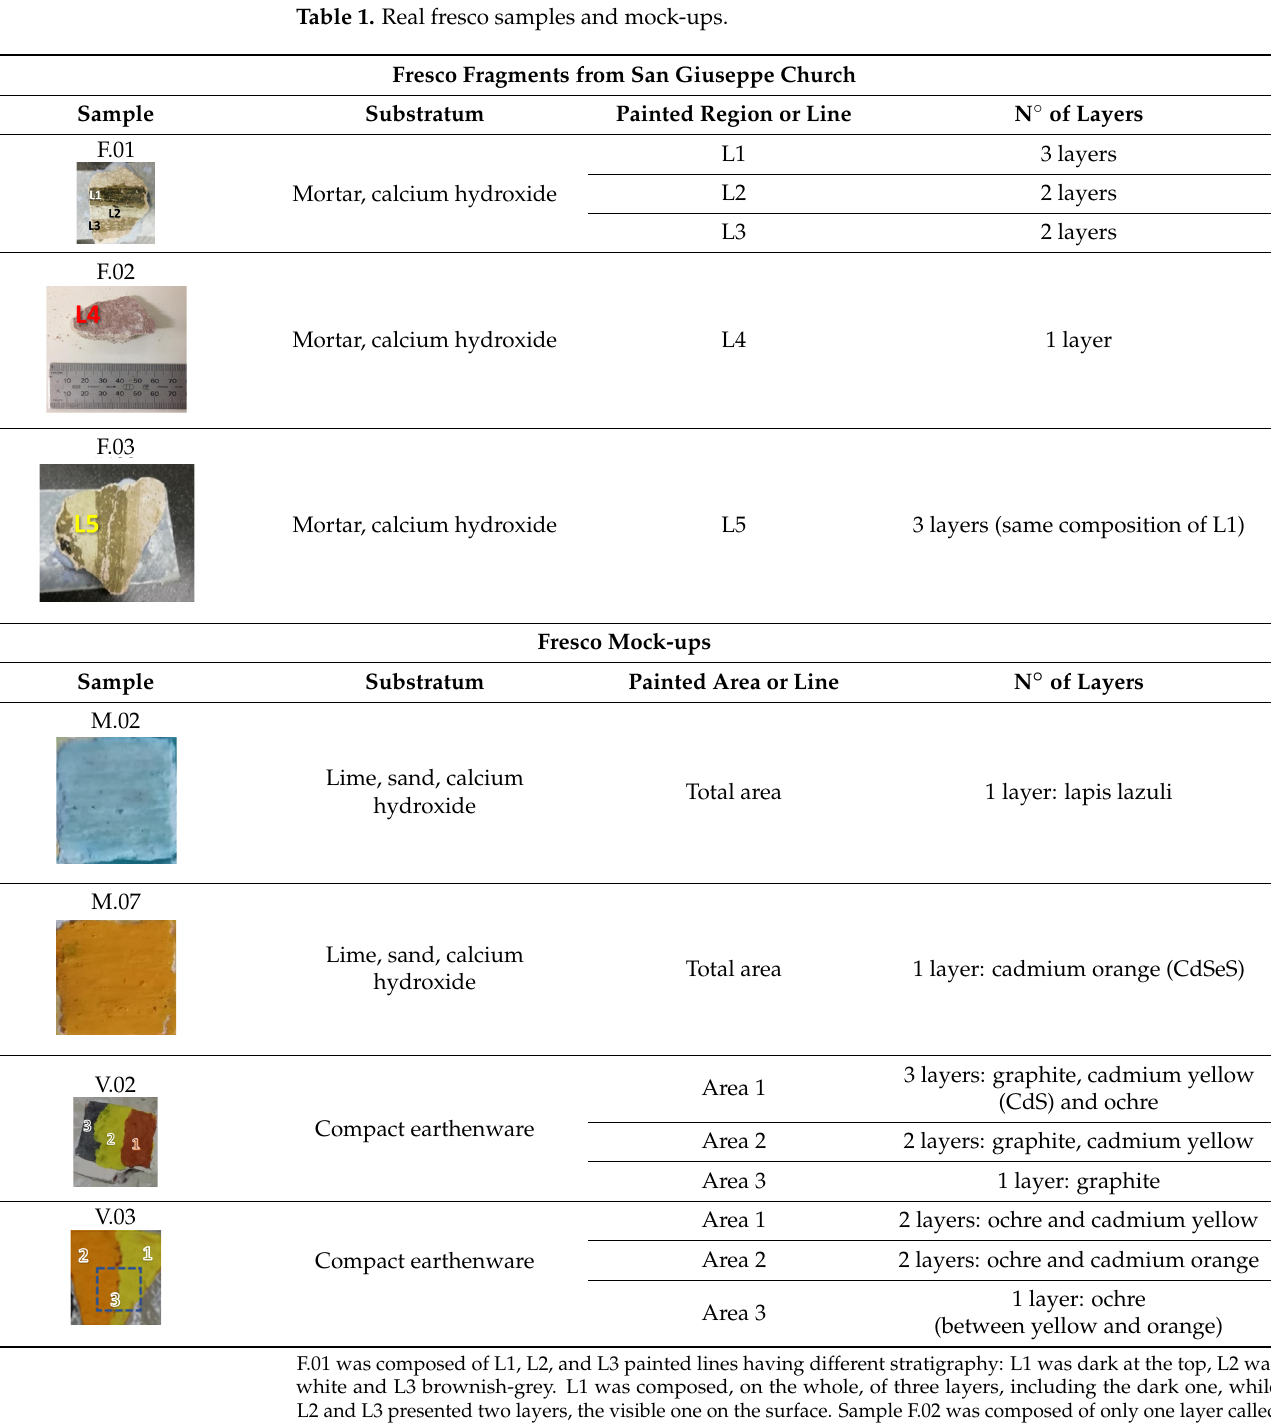
F.01 was composed of L1, L2, and L3 painted lines having different stratigraphy: L1 was dark at the top, L2 was white and L3 brownish ‐ grey. L1 was composed, on the whole, of three layers, including the dark one, while L2 and L3 presented two layers, the visible one on the surface. Sample F.02 was composed of only one layer called L4. In sample F.03 the only line analyzed was the brownish line, labeled as L5, equal in composition and structure to the L3 line of F.01.